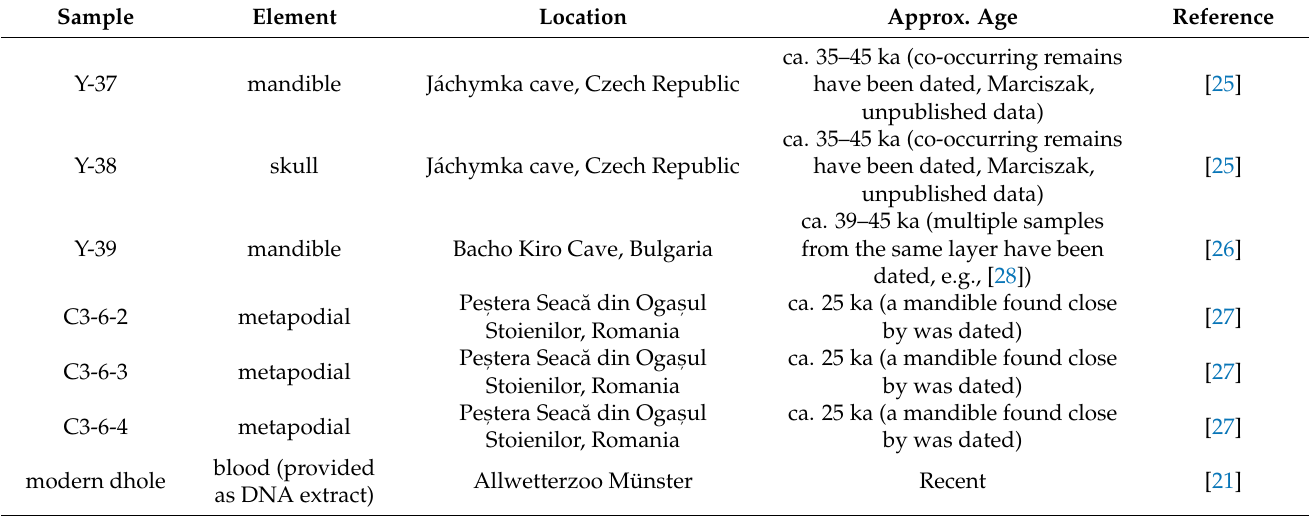
Table 1. Sample details for six ancient putative and one modern dhole sample. Additional sample information can be found in Table